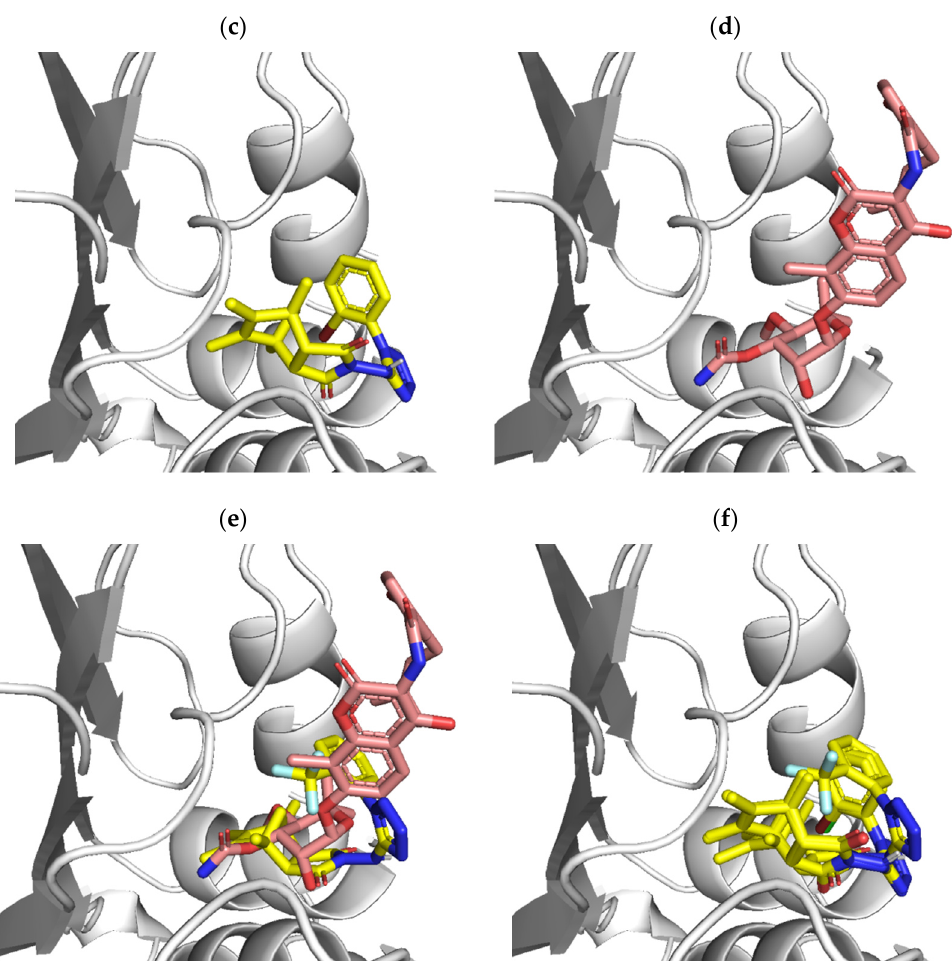
Figure 3. Molecular docking results and comparison to the Novobiocin-gyrase complex. ( a ) 1 , ( b ) 2 , ( c ) 3 , ( d ) Novobiocin (PDB ID: 4URO), ( e ) comparison of 1 and Novobiocin, ( f ) comparison of 1 , 2 , and 3 ligands.